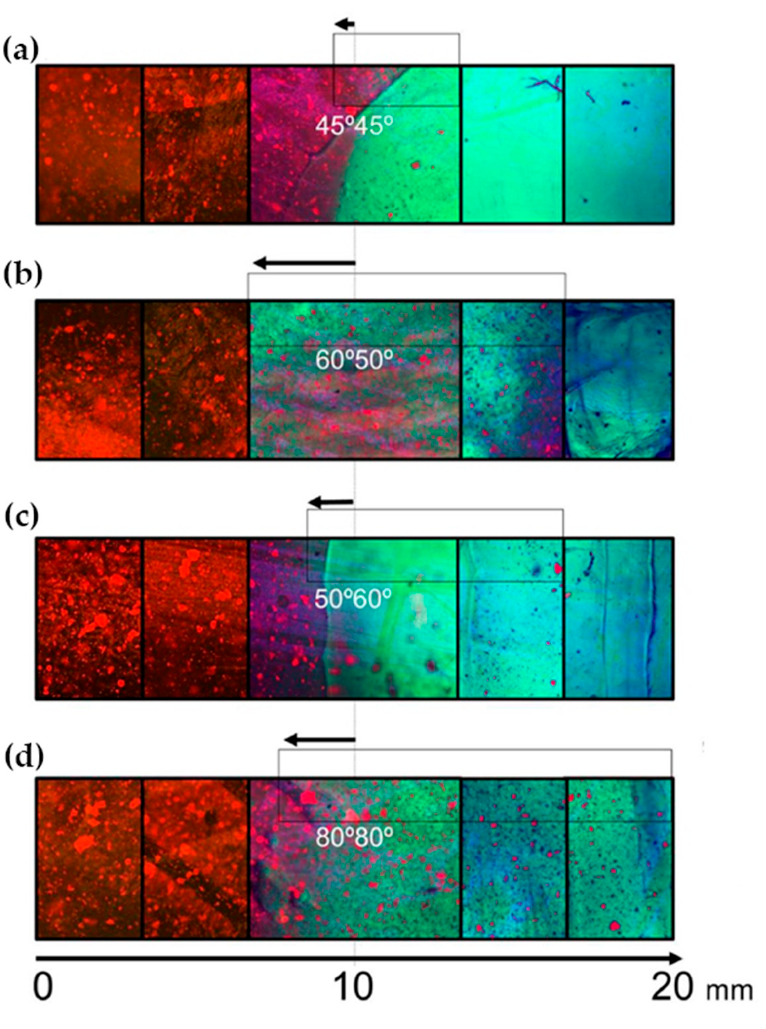
Figure 3. Gradients patterned by HAp-controlled dispersion resulting from different gel viscosi- ties/temperatures tracked by fluorescence microscopy using a GG modified with FITC (green) and the fluorescence of alizarin red-stained HAp (red) ( a ) 45–45 °C, ( b ) 60–50 °C, ( c ) 50–60 °C, and ( d ) 80–80 °C [17].